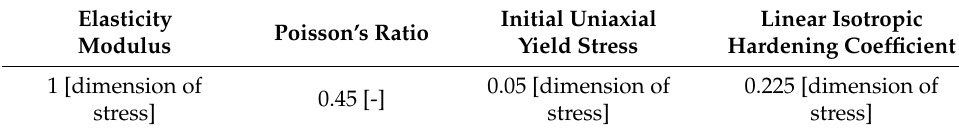
Table 1. The material parameters of the elasto-plastic model of Simo and Miehe.